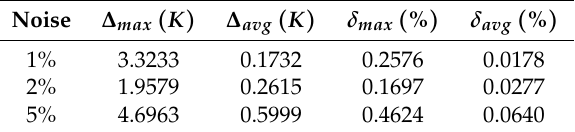
Table 2. Errors of temperature reconstruction in the control points obtained for measurements read at every 0.01m (one step